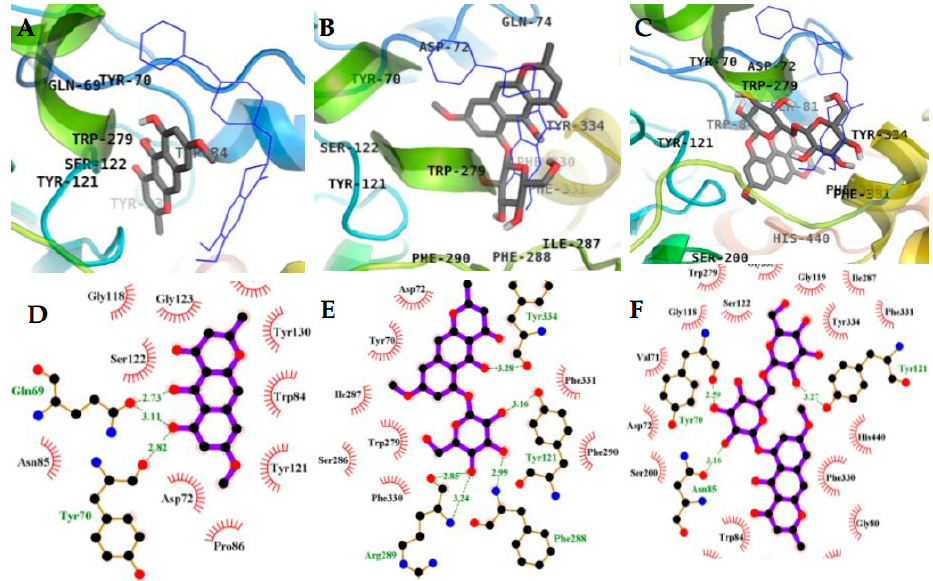
Figure 6. Inhibition mode of 1 ( A ); 2 ( B ); and 3 ( C ) for the AChE allosteric site with donepezil (blue line) ( A ). 2D ligand interaction diagram of AChE allosteric inhibition by 1 ( D ); 2 ( E ); and 3 ( F ). Dashed green lines indicate H-bonds. Carbons are in black, nitrogens in blue, and oxygens in red.